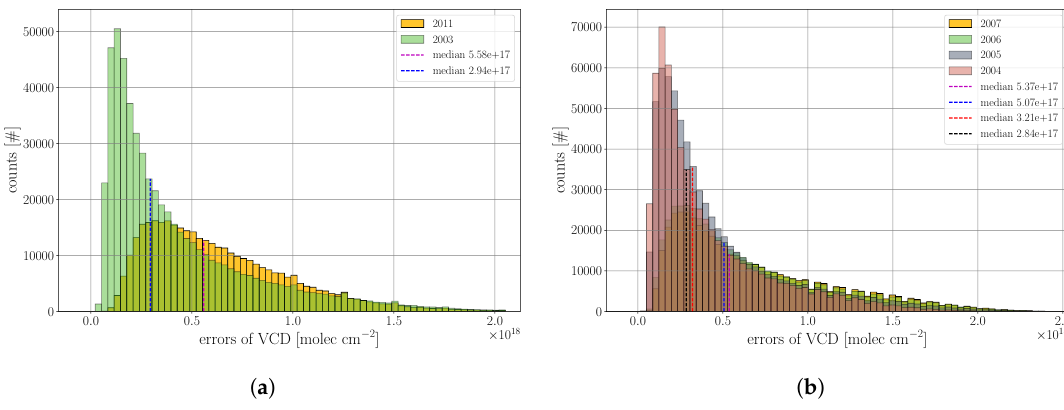
Figure 3. Histogram of the errors of the CO columns (defined in Equation (20)), represented as the unnormalized error probability function (also see Section 4.2.1 in Gimeno García et al. [8]). The data content is the global fraction of CO columns that survived after postprocessing of the BIRRA retrieval output. The dashed lines indicate the respective median. Note the different range in the x-axis. ( a ) The first and last year of the nominal SCIAMACHY operation covering the complete time span; ( b ) The occurrence frequency of total column errors for the years 2004 through 2007 indicate a substantial degradation of the quality of the CO product from 2006 onward (blue and magenta dashed lines). The years 2003 through 2005, however, show similar and significantly smaller errors.